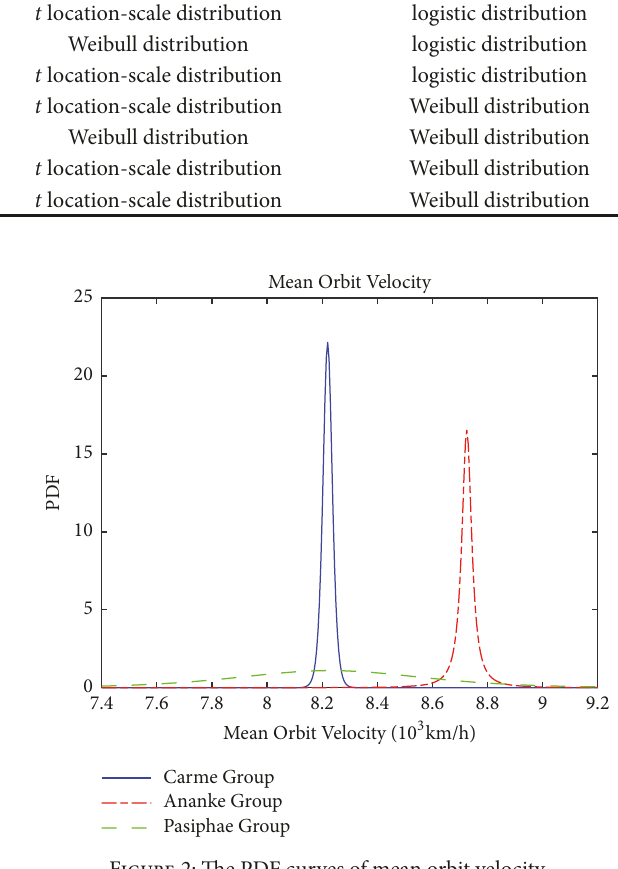
Figure 1: The PDF curves of semi-major axis around Jupiter. Figure 2: The PDF curves of mean orbit